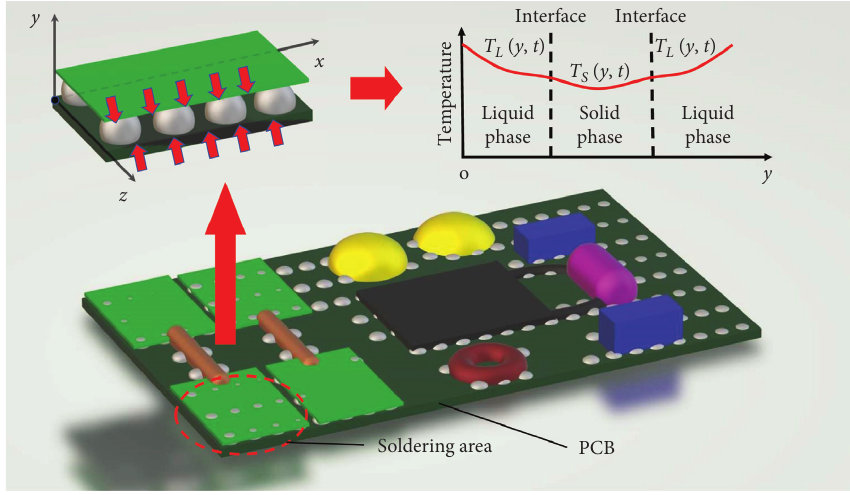
Figure 3: Phase transformations in thawing